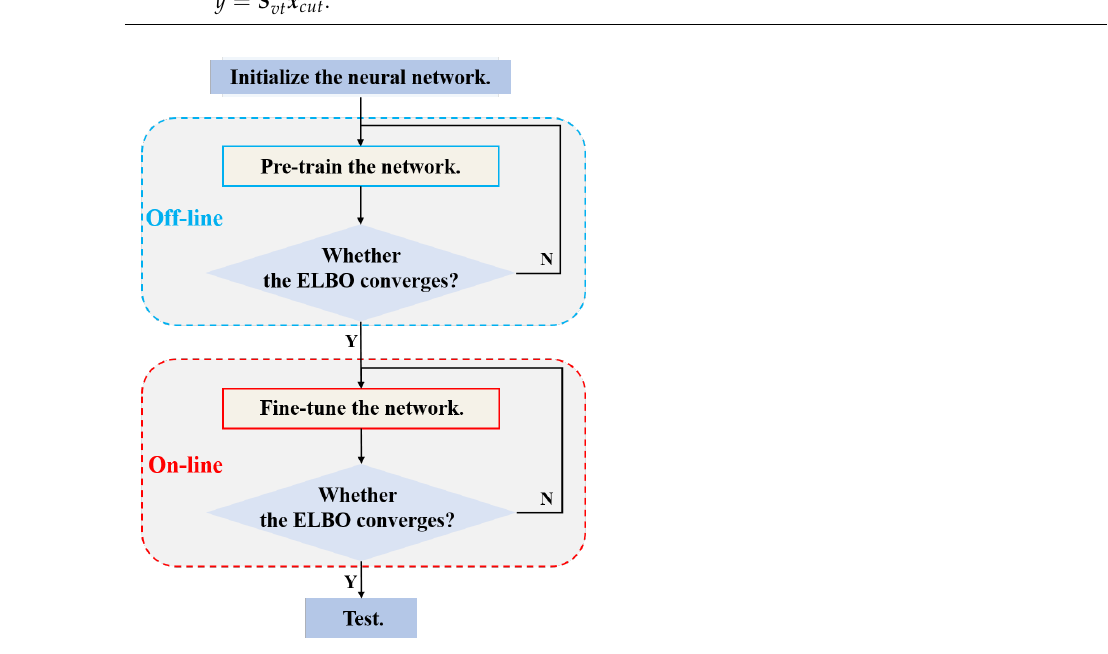
Figure 3. Flow chart of BAMCV −